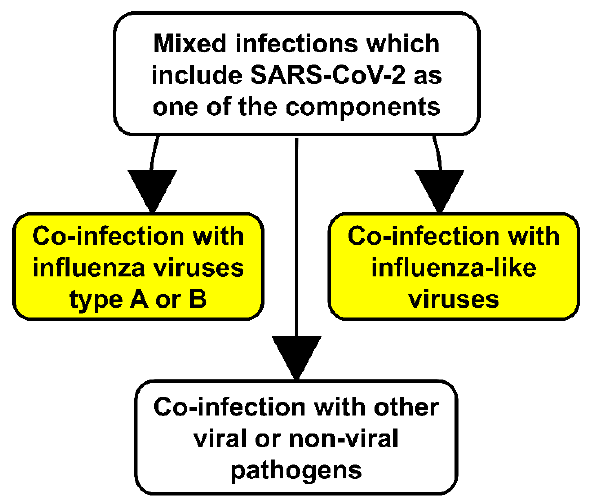
Figure 2. The nature of mixed infections of SARS-CoV-2 with other pathogens in the COVID-19